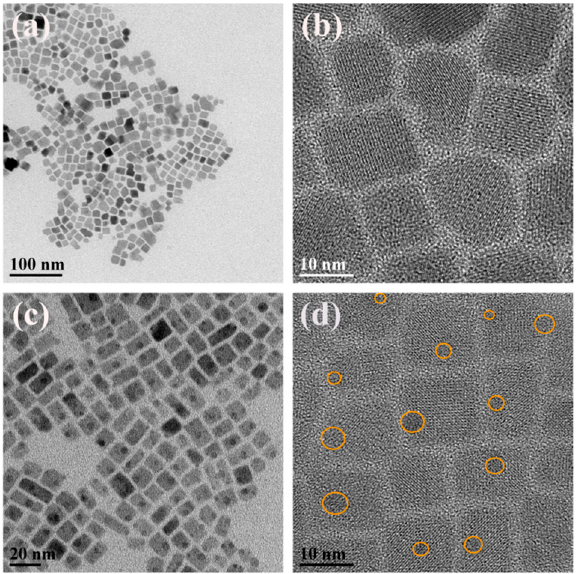
Figure 1. ( a ) Typical TEM overview image of sample a; ( b ) HRTEM image of selected lager sample a; ( c ) Typical TEM overview image of sample d; ( d ) HRTEM image of selected lager sample